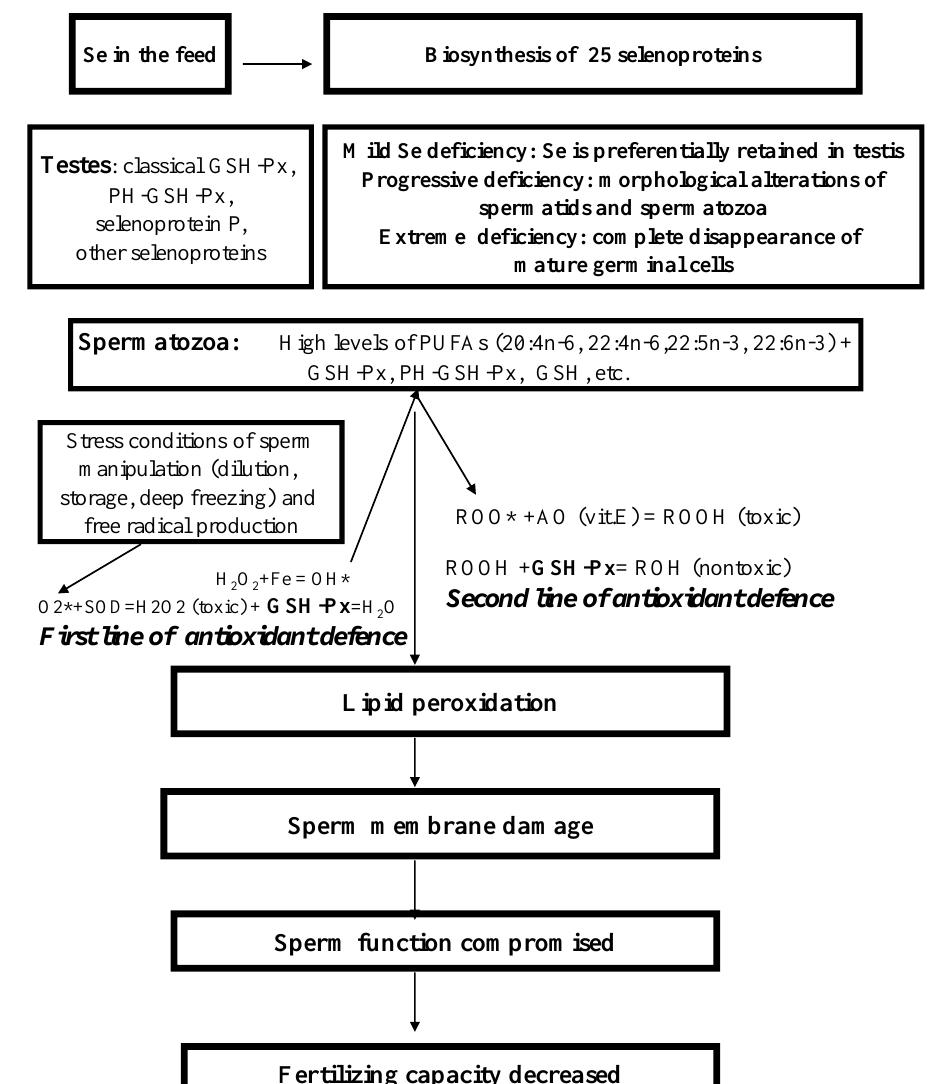
Figure 2. Selenium and male fertility (Adapted from Surai,